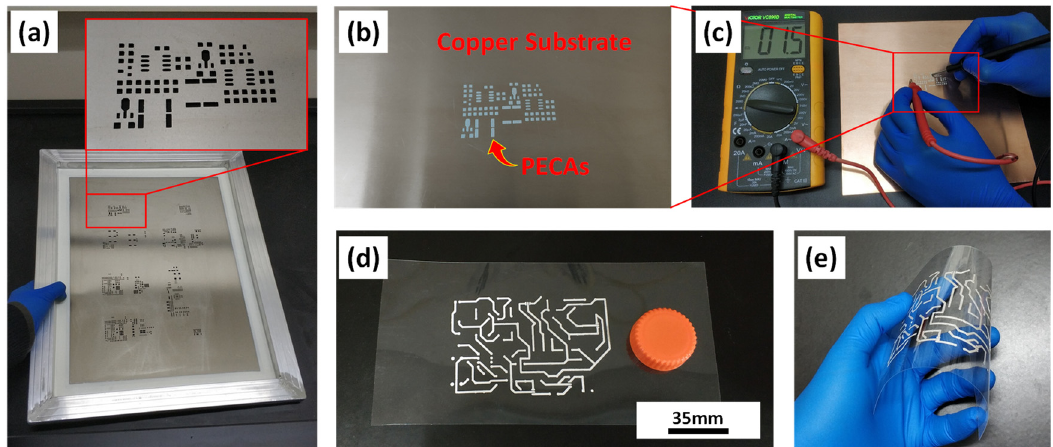
Figure 6. ( a ) Stencil printing mask prepared by laser beam cutting with the thickness of 100 μ m; ( b ) Stencil printing PECA patterns corresponding to the mask on the copper substrate playing the same role as Sn-Pb solders pastes; ( c ) Photographs of the relative resistance of the PECAs after curing; ( d , e ) Photographs of printable flexible circuits on a PET film. The printed circuits still maintained excellent adhesion performance during the bending process.